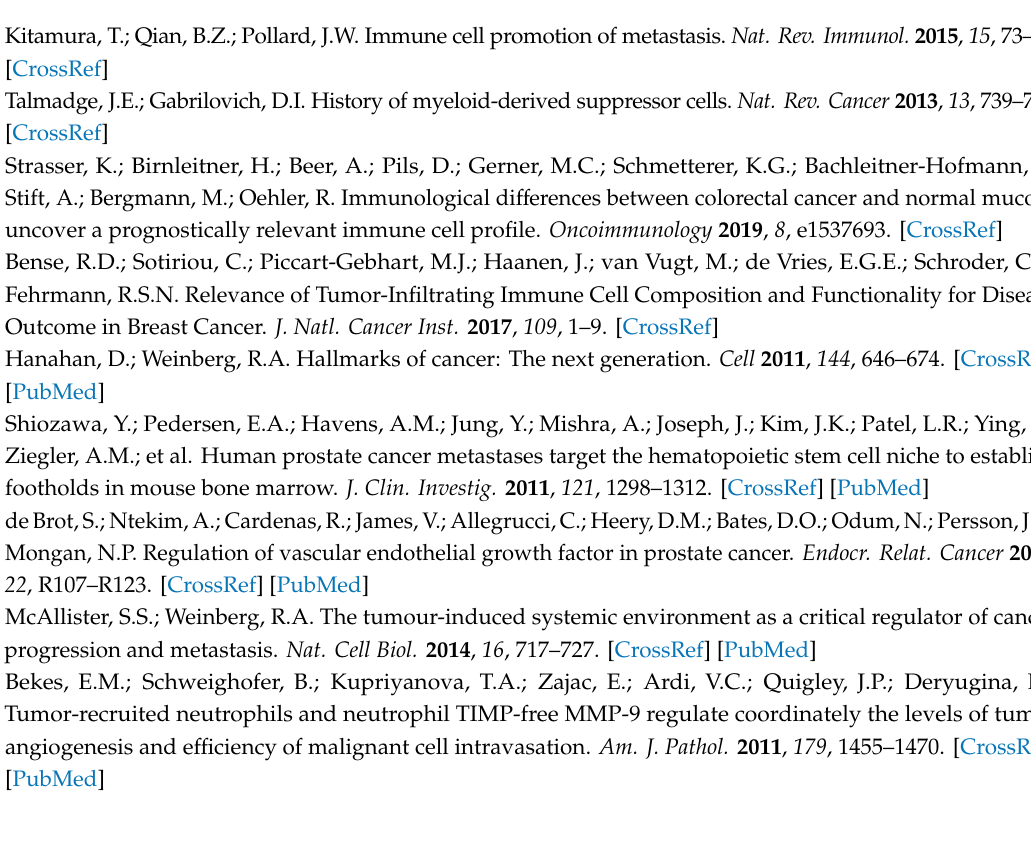
Figure S1: Original Western